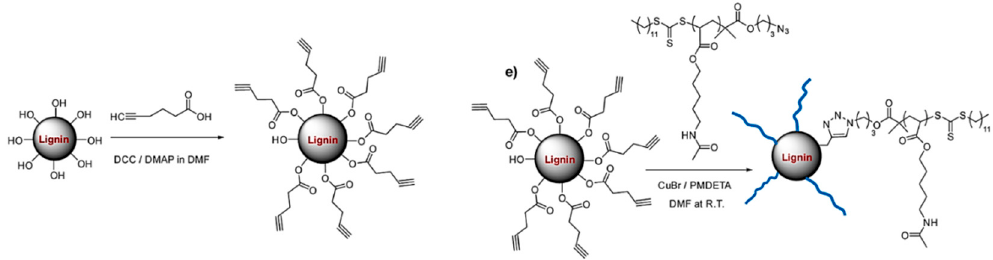
Figure 33. Synthesis of Lignin–graft–poly(5-acetylaminopentyl acrylate). Reproduced with permission [106].